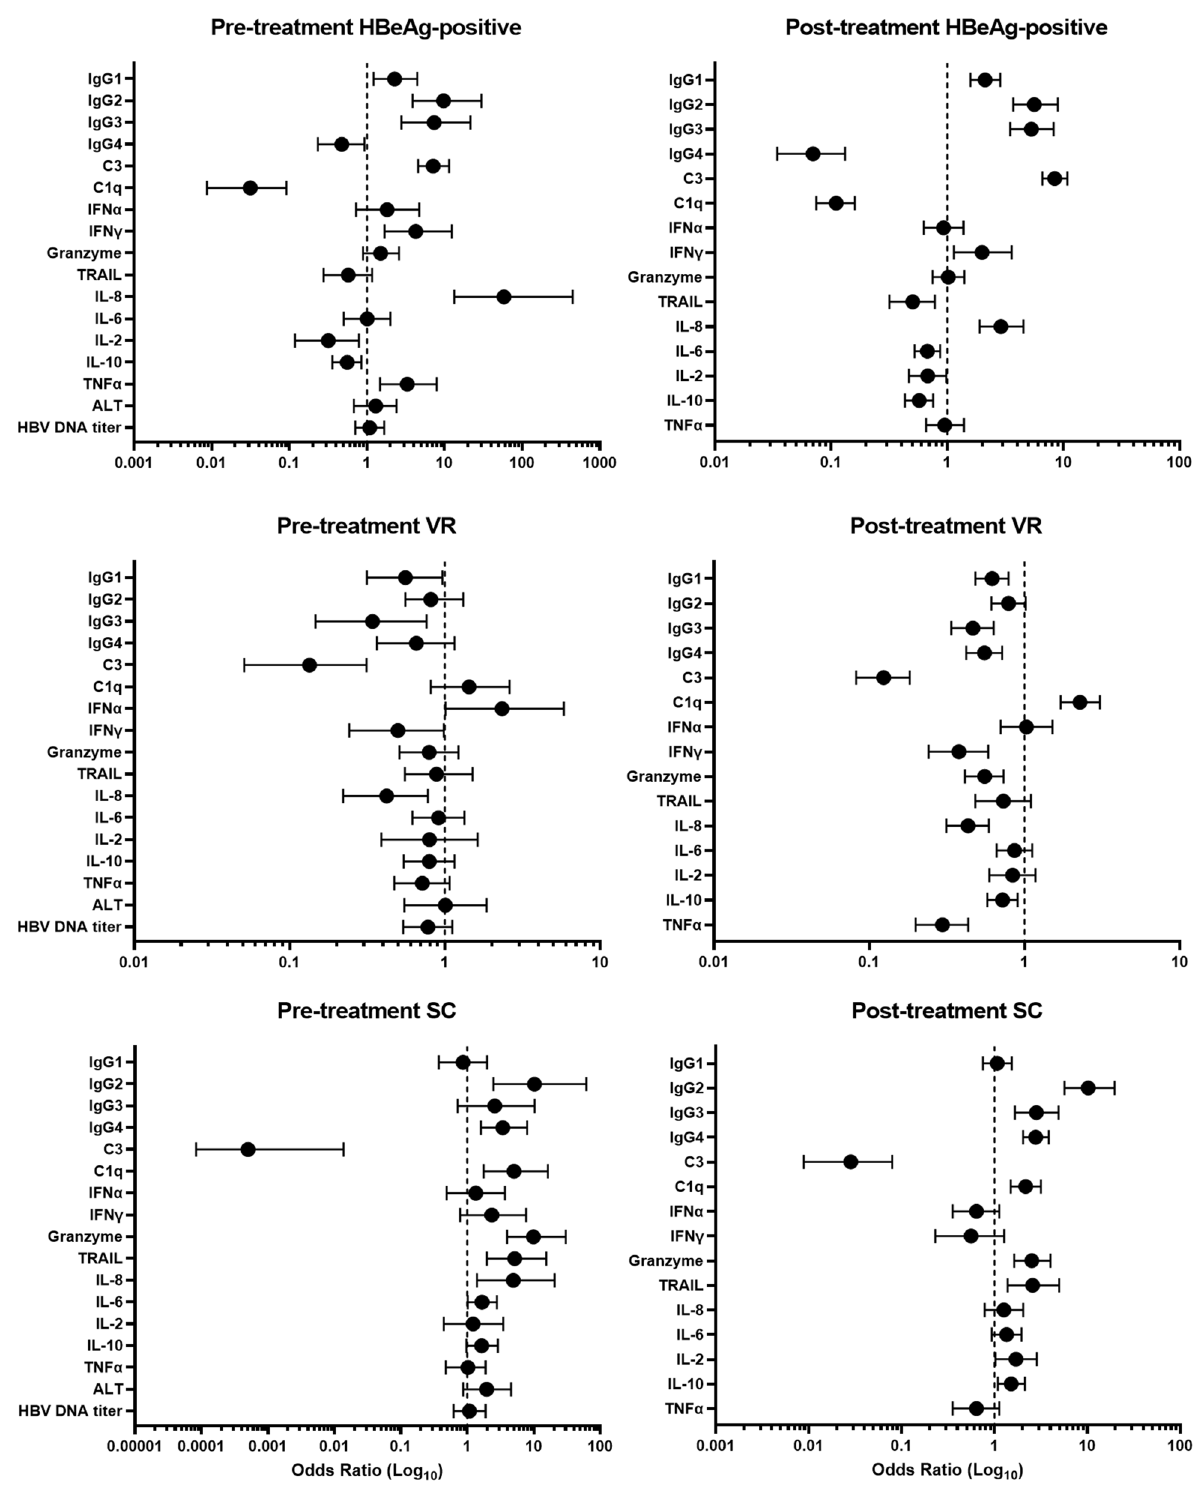
Figure 8. Association between IgG1–4, C3, C1q, cytokines and CHB patients with different treatment outcomes. (A) Forest plot of pre-treatment (baseline) levels of IgG1–4, C3, C1q, and cytokines in HBeAg- positve vs. HBeAg-negative; VR vs. PVR; SC vs. non-SC. (B) Post-treatment levels of the analytes in HBeAg- positve vs. HBeAg-negative; VR vs. PVR; SC vs. non-SC. Odd ratios were calculated using simple logistic regression models fitted with the outcome variables. The horizontal lines of each variable represent the 95% confidence interval of each odd